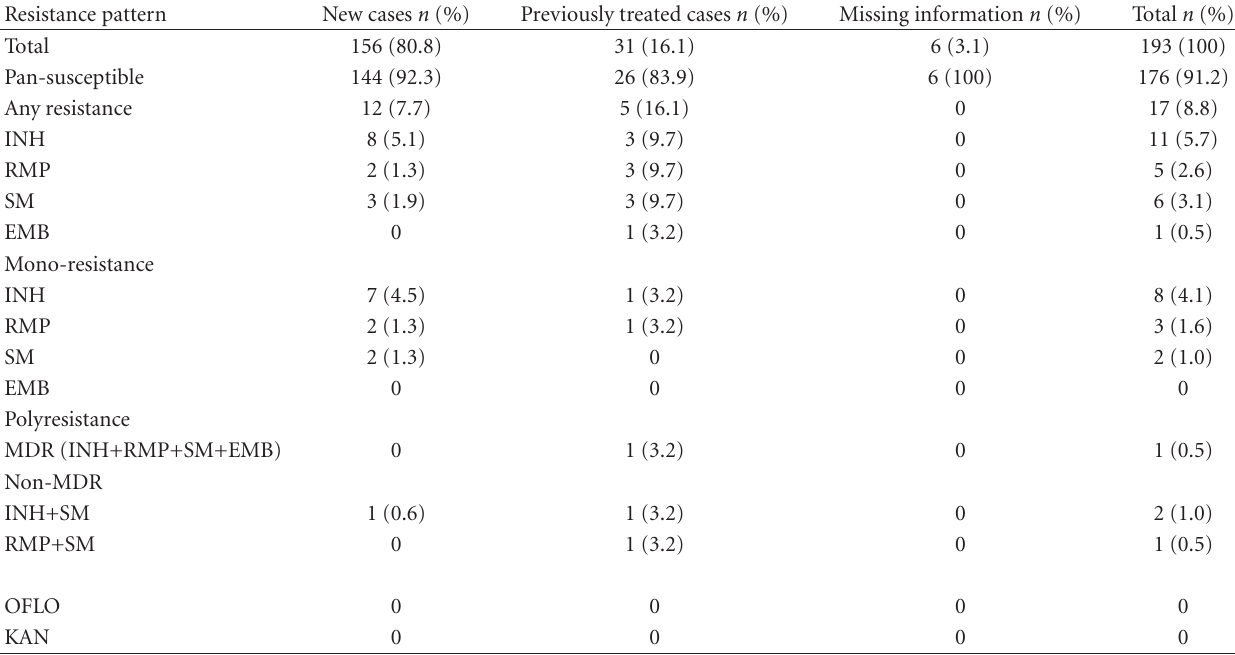
Table 1: Phenotypic drug resistance patterns to first-line and second-line antituberculosis drugs in 193 M. tuberculosis isolates from treated and previously treated